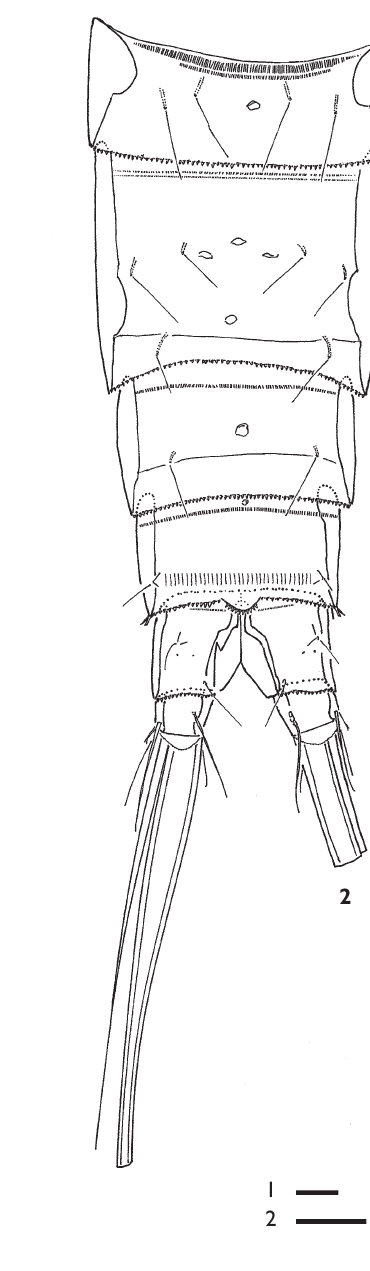
Figures 1-2. Chaulionyx paivacarvalhoi sp. n. ♀ : 1 habitus, dorsal [ * = integumental pit; ■ = pore ; ● = chitinous patch 2 urosome, dorsal. Scale bars = 10